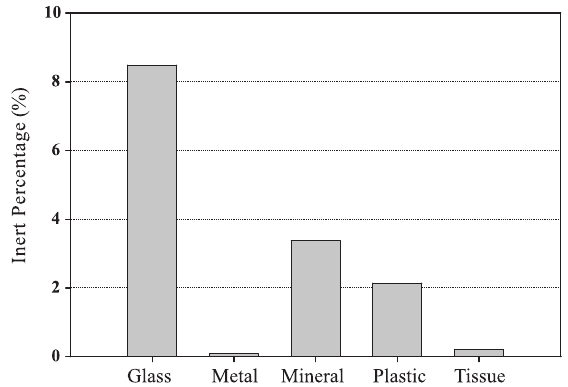
figure 3. Gravimetric analysis of the collected msW compost (ComLurB, 2010).